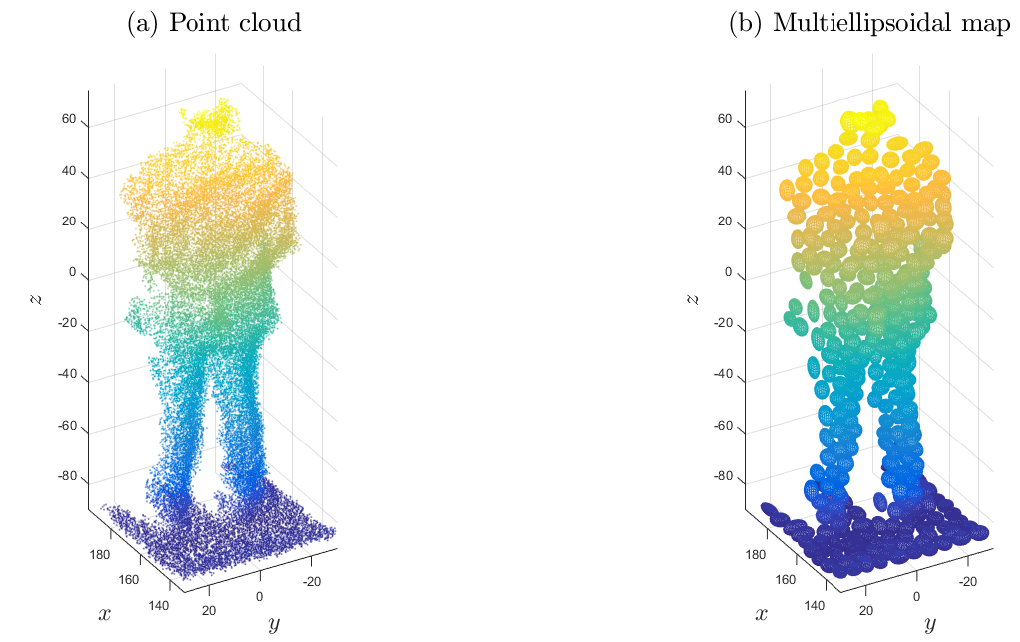
Figure 6. Experiment 4.